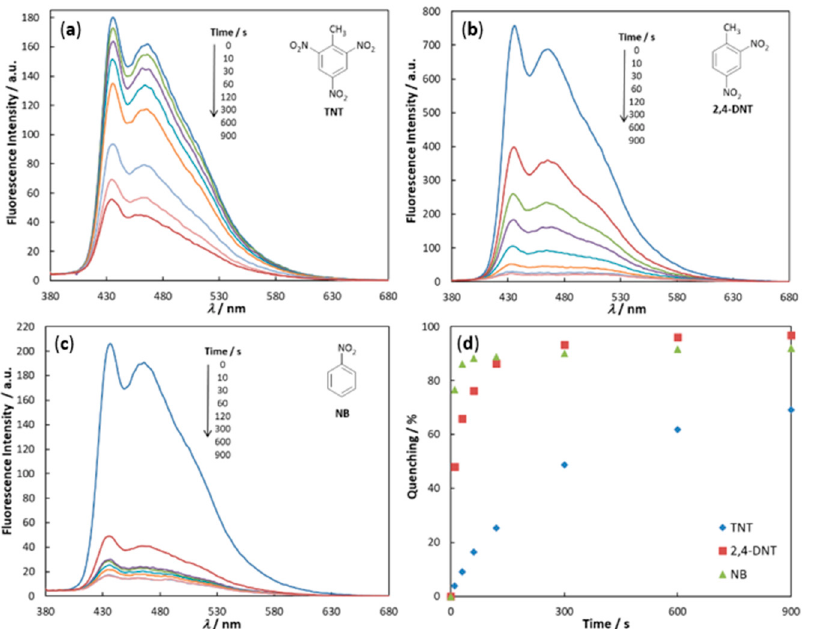
Figure 3. Time ‐ dependent emission intensities ( a to c ) and fluorescence quenching efficiencies ( d ) of Figure 3. Time-dependent emission intensities ( a – c ) and fluorescence quenching e ffi ciencies ( d ) of Calix ‐ PPE ‐ 2,7 ‐ CBZ films ( ≈ 20 nm) after being exposed to saturated TNT (10 ppb) ( a ), 2,4 ‐ DNT (190 Calix-PPE-2,7-CBZ films ( ≈ 20 nm) after being exposed to saturated TNT (10 ppb) ( a ), 2,4-DNT (190 ppb) ppb) ( b ) and NB (318 ppm) ( c ) vapours at 25 °C ( λ exc = 360 nm). ( b ) and NB (318 ppm) ( c ) vapours at 25 ◦ C ( λ exc = 360